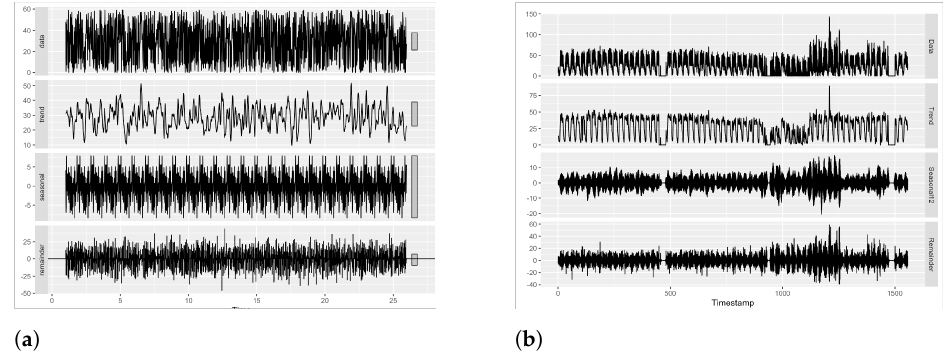
Figure 21. Comparing trends and patterns in generated and real data. ( a ) Components of generated data. ( b ) Components of real